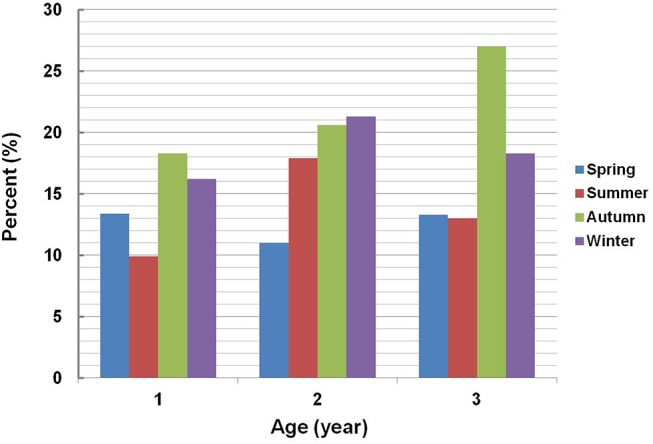
Comparison of the prevalence of vitamin D deficiency in young children by age and season.Vitamin D deficiency was defined as a serum 25(OH)D level of <50 nmol/L. All the children were stratified by age into three subgroups (aged 1, 2 and 3). In each subgroup, the subjects were further stratified by season of serum collection. The prevalence of vitamin D deficiency in each season was calculated separately within each age group.